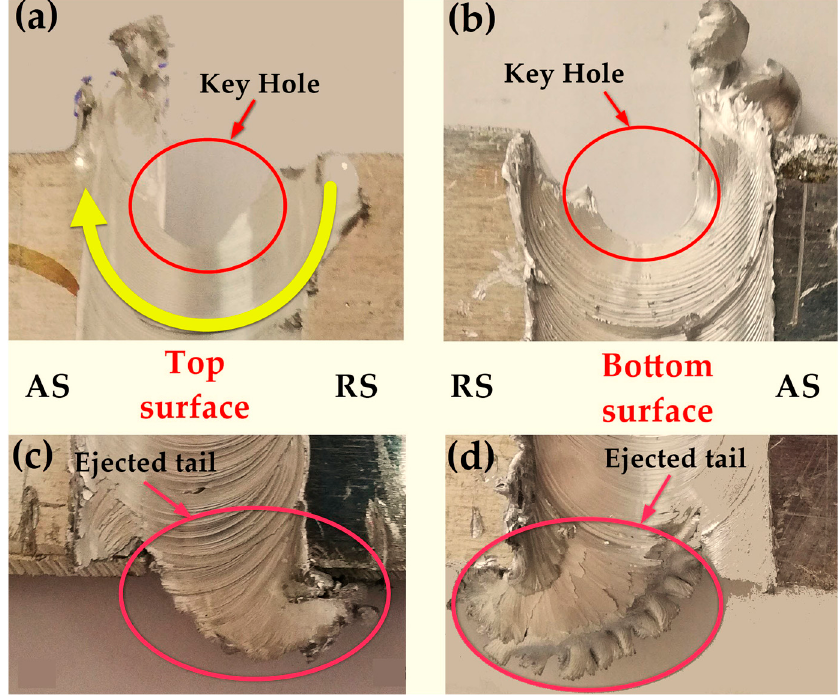
Figure 15. Top view of the BT-FSW of aluminum at start and end region; ( a and b ) the exit regions; ( c and d ) the entry regions .